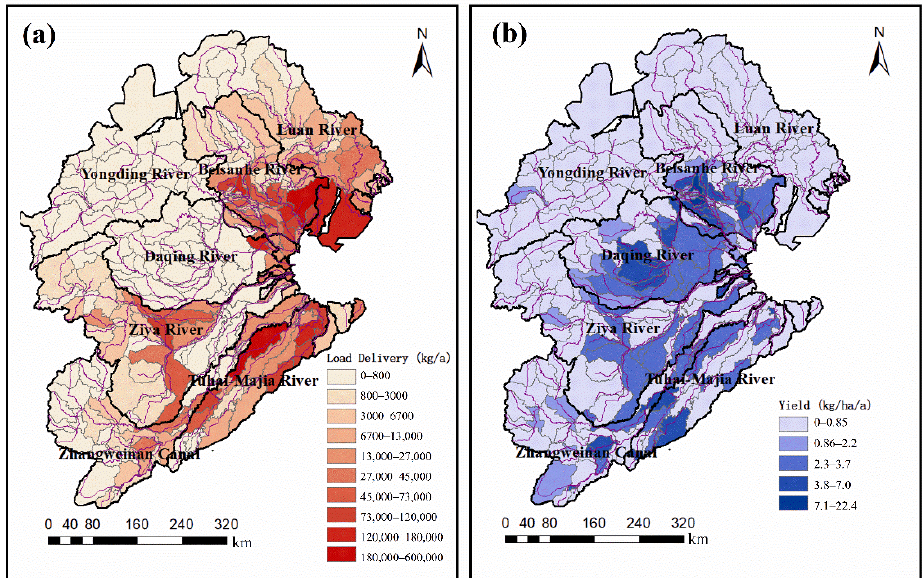
Figure 10. ( a ) Loads and ( b ) yields of NH 4+ -N delivered to the target outlets in